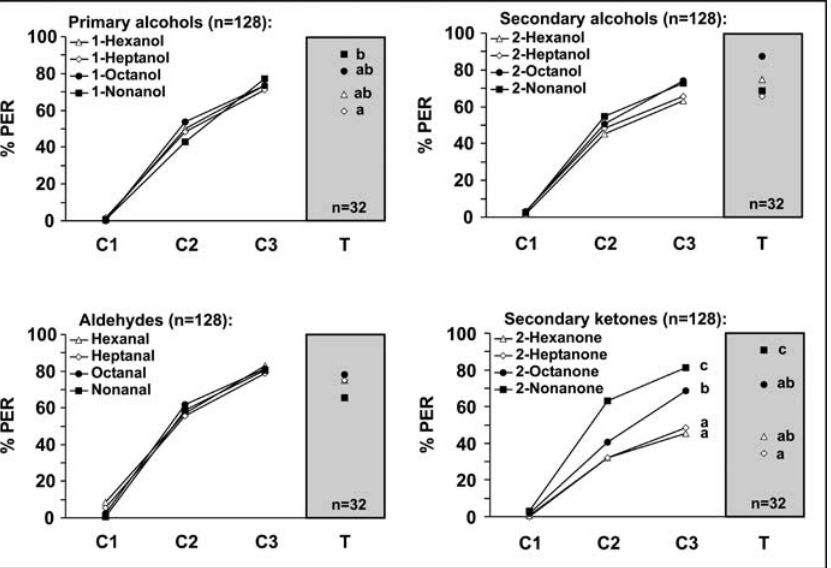
Figure 1. Acquisition Curves for Primary Alcohols, Secondary Alcohols, Aldehydes, and Ketones The ordinate represents the percentage of proboscis extensions to the training odour (CS). The abscissa indicates the conditioning trials (C1, C2, C3) and the test with the CS (T). The curves correspond to molecules with 6 (white triangles), 7 (white diamonds), 8 (black circles) and 9 carbons (black squares); ( n = 128 bees for each curve). As not all 128 bees were tested with the odour used as CS, the sample size in the tests was smaller ( n = 32). Different letters (a, b, c) indicate significant differences either between acquisition curves for different chain-length molecules (in the case of the ketones) or between test responses (post hoc Scheffe´ tests). DOI: